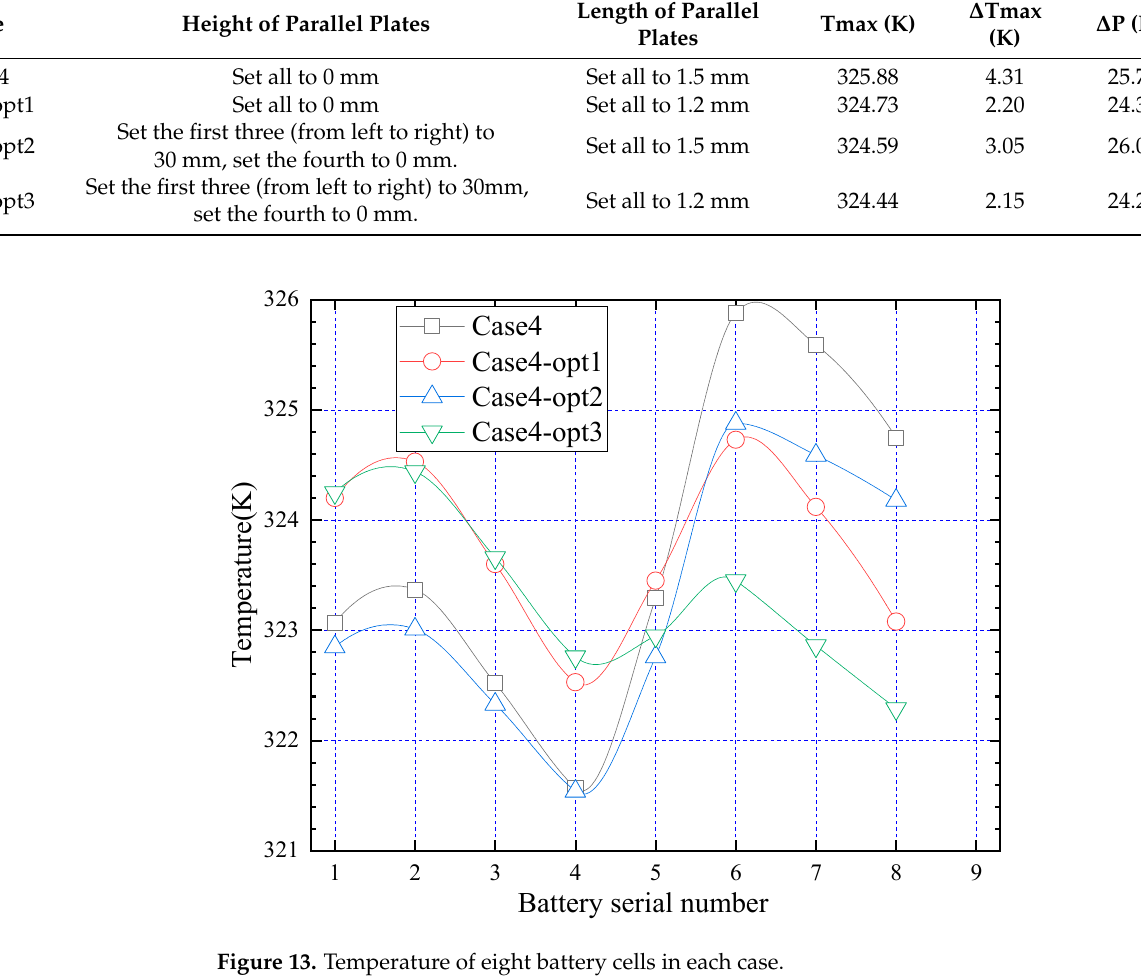
Figure 13. Temperature of eight battery cells in each case.